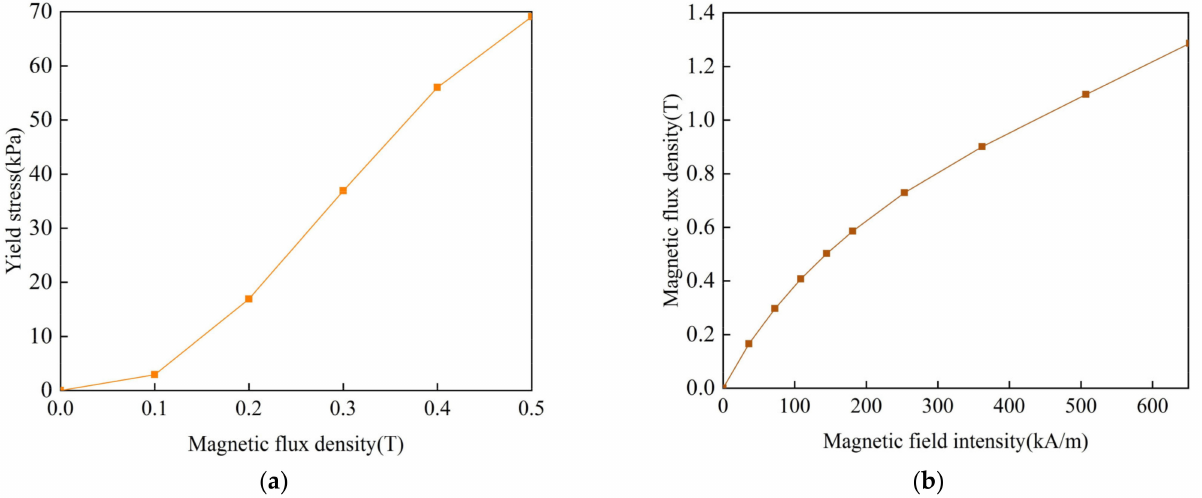
Figure 7. Performance of magnetorheological fluid. ( a ) τ -B curve. ( b ) B-H